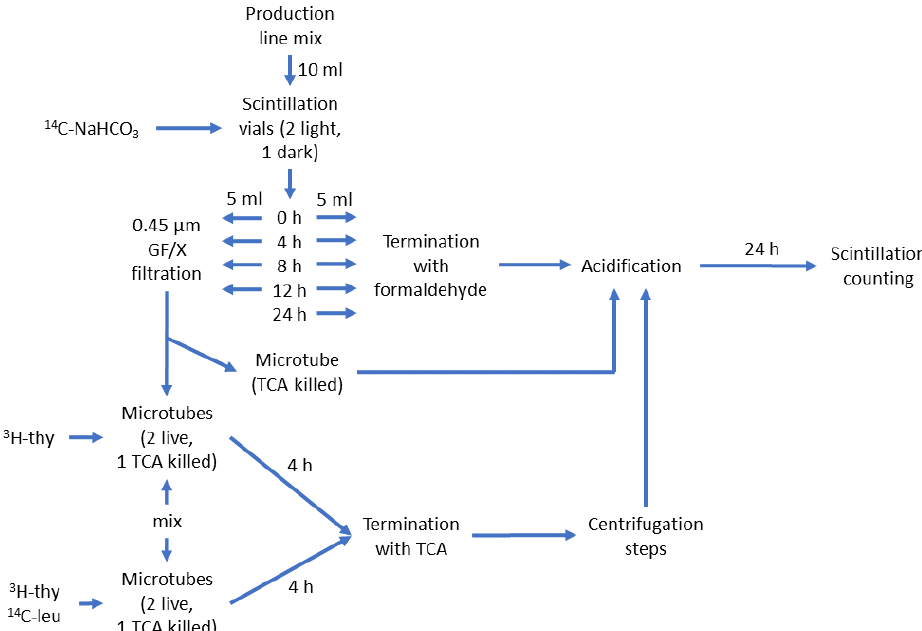
Figure 2. Schematic description of the production line of the DOM release experiment. The schematic starts at the top from the “Production line mix”, which consisted of phytoplankton culture (90%Vol.) and inoculum of seawater bacteria (explained in Fig. 1a). This was divided into five 10mL aliquots in 20mL scintillation vials, which were spiked with 125µL of 23.43µCimL − 1 14 C-NaHCO 3 and incubated in light for 0 to 24h. At 0, 4, 8, and 12h one set of incubation vials was divided in two. One half were terminated with 0.1% formaldehyde for 14 C-NaHCO 14 C-NaHCO 3 -incorporation measurement (i.e., primary production). To remove the remaining 3 prior to scintillation counting, 24h acidification with HCl was used. The other half was filtered to remove the majority of 14 C-labeled phytoplankton and bacterial cells and mixed (50 : 50Vol.) with non-spiked production line mix (termed “mix” in the lower left part of the schematic). This new mixture was then spiked with either only 3 H-thymidine or both 3 H-thymidine and 14 C-leucine and incubated for 4h. The mixture spiked with 3 H- thymidine was used to measure incorporation of 14 C-labeled DOC originating from phytoplankton into bacterial biomass ( 3 H-thymidine incorporation was measured as a control for bacterial activity). The mixture spiked with 3 H-thymidine and 14 C-leucine was used to measure incorporation rate of both radioisotope tracers and, subsequently, bacterial production based on both tracers. These mixtures were terminated with trichloroacetic acid (TCA, final concentration: 5%) and measured according to the centrifugation method (Smith and Azam, 1992). Instagel Plus (PerkinElmer) was used as the scintillation cocktail, and liquid scintillation counting was done with Wallac 1414